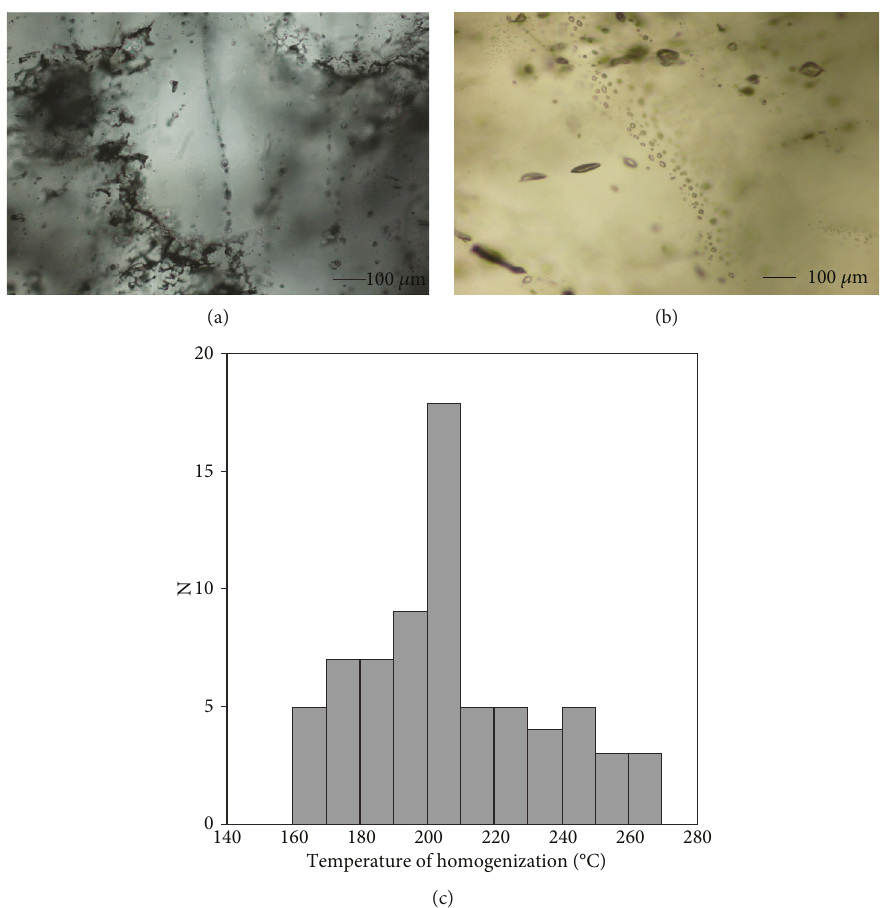
Figure 9: (a) Microphotograph of secondary trails of Type 1 two-phase liquid-rich ( L + V ) fl uid inclusions; (b) microphotograph of secondary trails of Type 2 liquid only (L) fl uid inclusions; (c) histogram of the homogenization temperatures of the studied Type 1 fl uid inclusions. N =number of